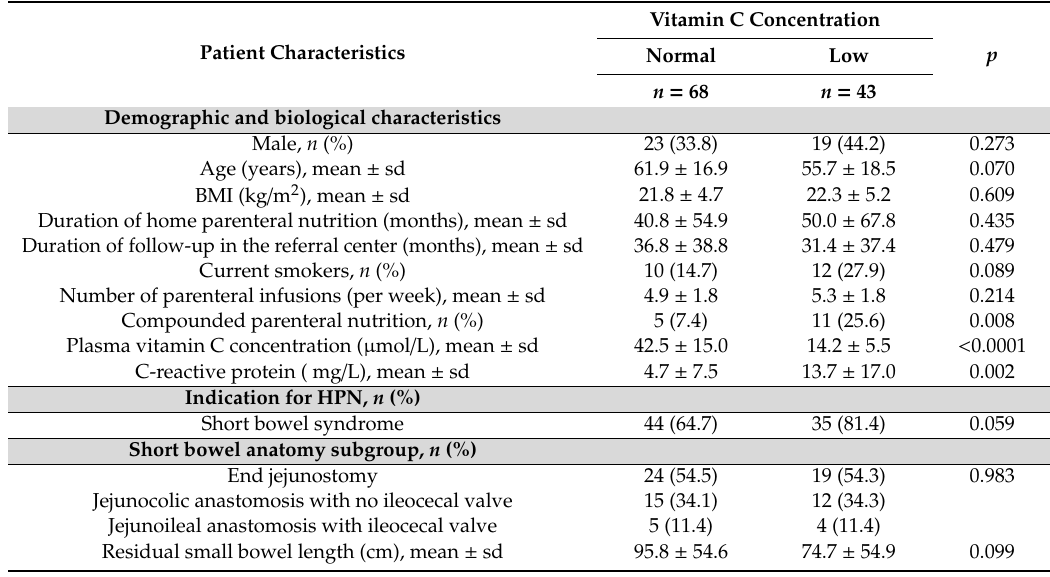
Table 4. Comparison of patients receiving only the commercial multivitamin preparation for their intravenous vitamin C supplementation according to their blood level of vitamin